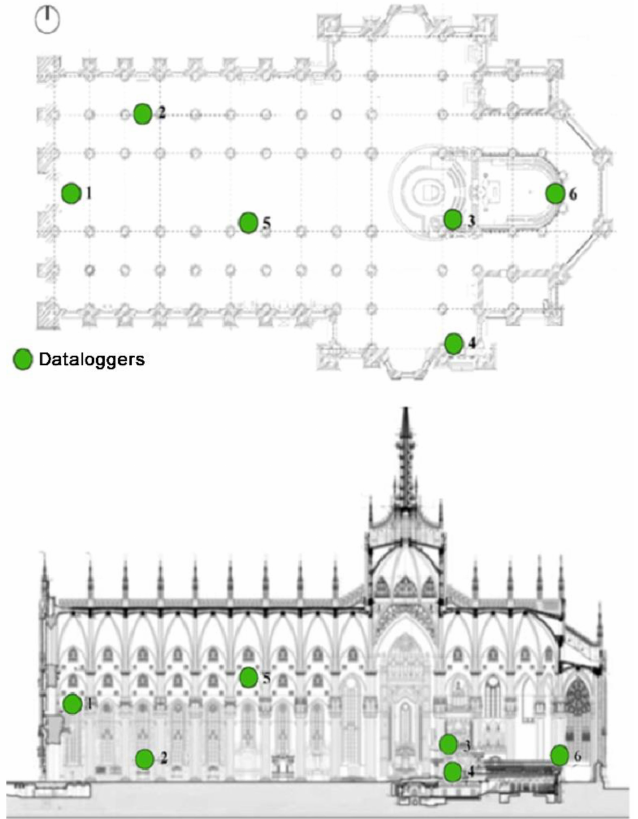
Figure 3. Location of the six dataloggers distributed in the indoor space of the